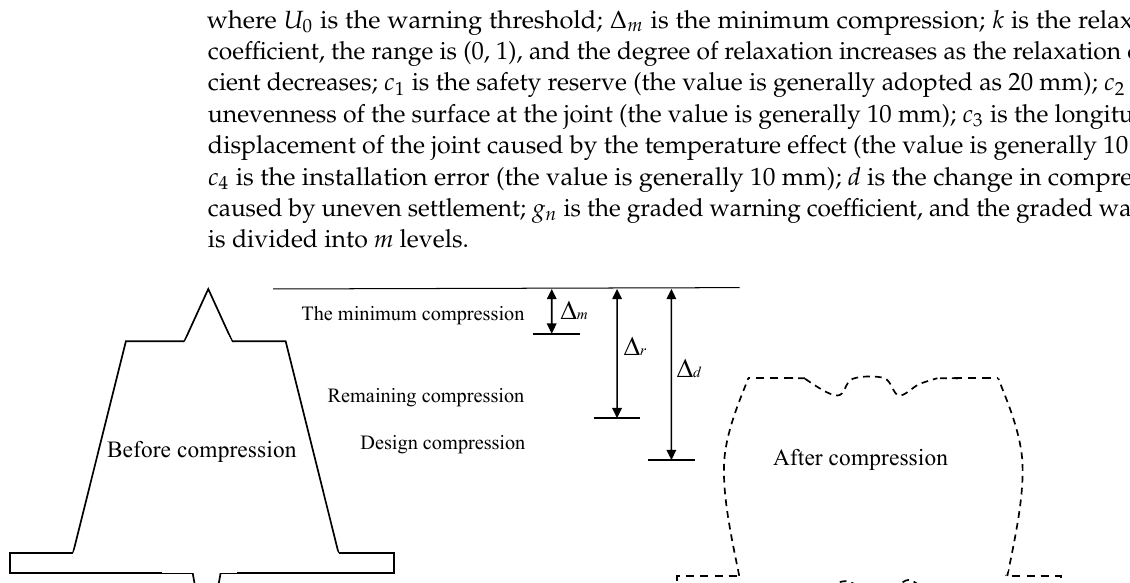
Figure 7. The relationship of compression characteristics of GINA gasket (redrawn according to Liu et al. [25]).